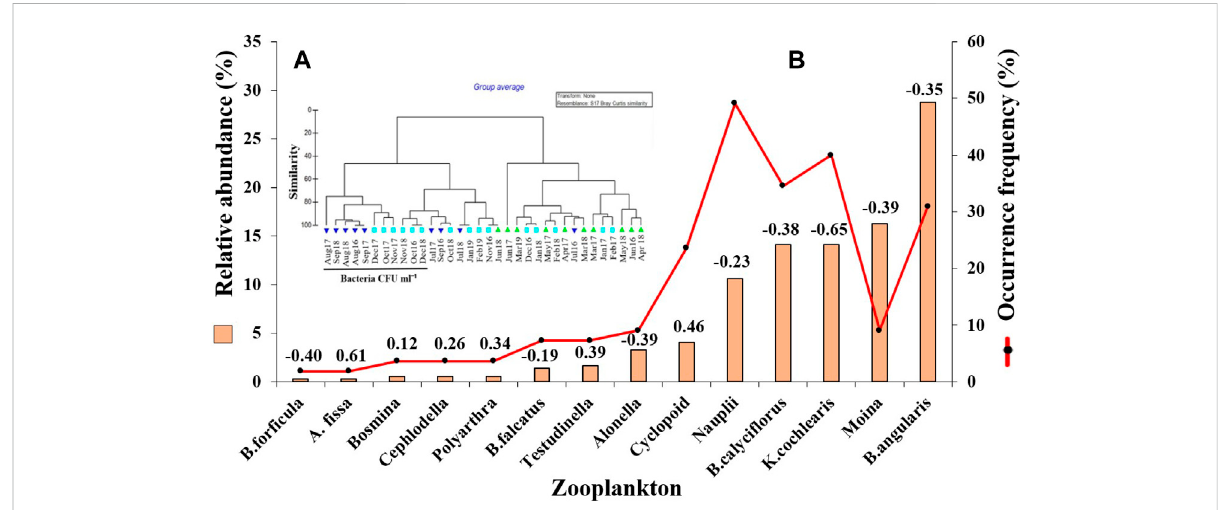
FIGURE 4 Results of time series study for screening of biopuri fi ers (A) Hierarchical dendrogram of 36 samples identi fi ed by the Bray Curtis cluster analysis for water quality parameters; (B) Relative abundance and occurrence frequency of 14 highly abundant zooplankton species, collected at time series study site (Kalighat) in the River Ganges during June 2016 to March 2019 in the vicinity of the sewage drain mouth.